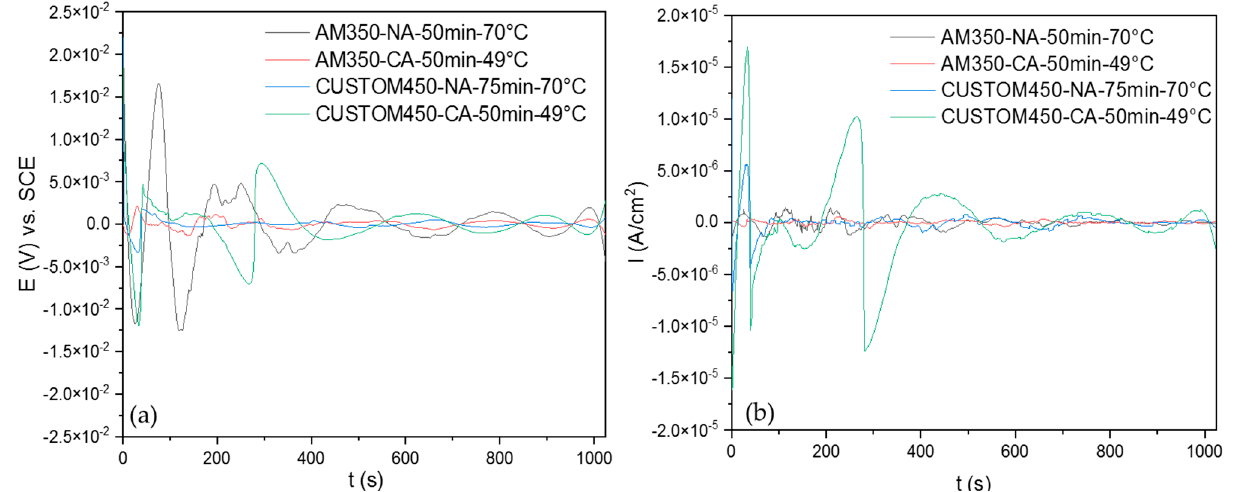
Figure 1. Electrochemical noise–time series: ( a ) EPN and ( b ) ECN, for CUSTOM450 and AM350 passivated stainless steels immersed in 5 wt. % NaCl solution.